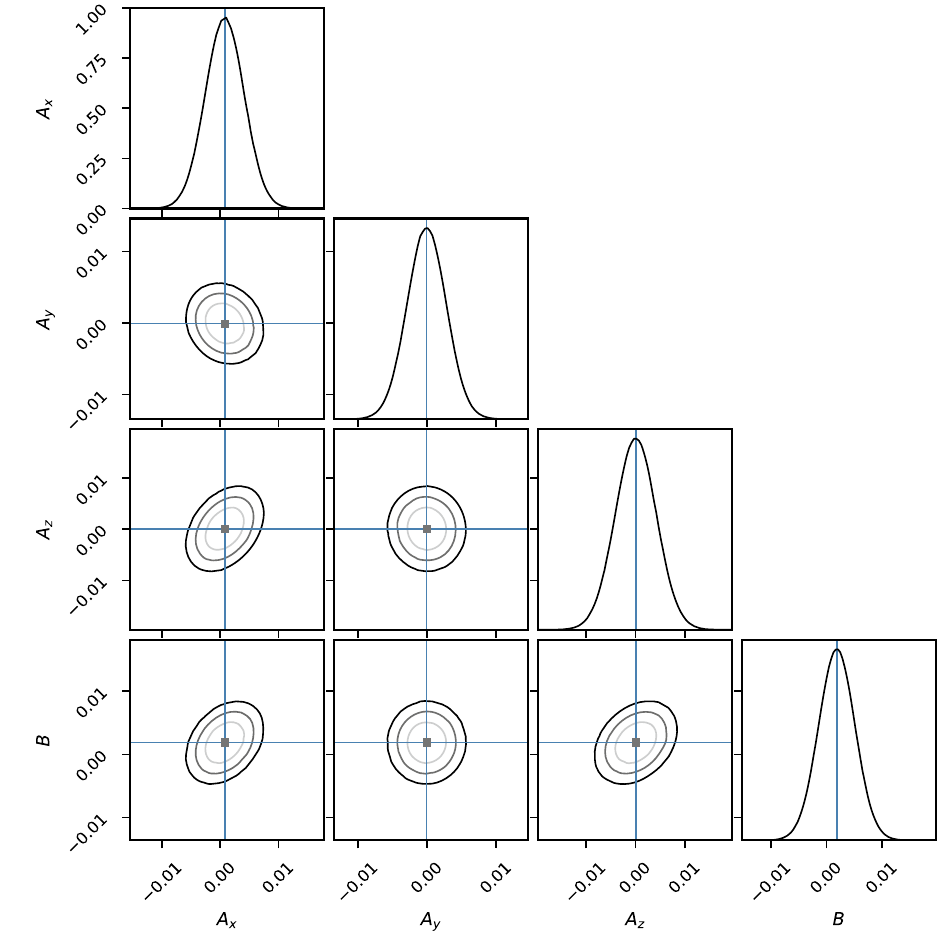
Fig. 10 Probability distribution functions of rectangular components of dipole A and monopole B for JLA data set directly using ( A x , A y , A z ) as fitted